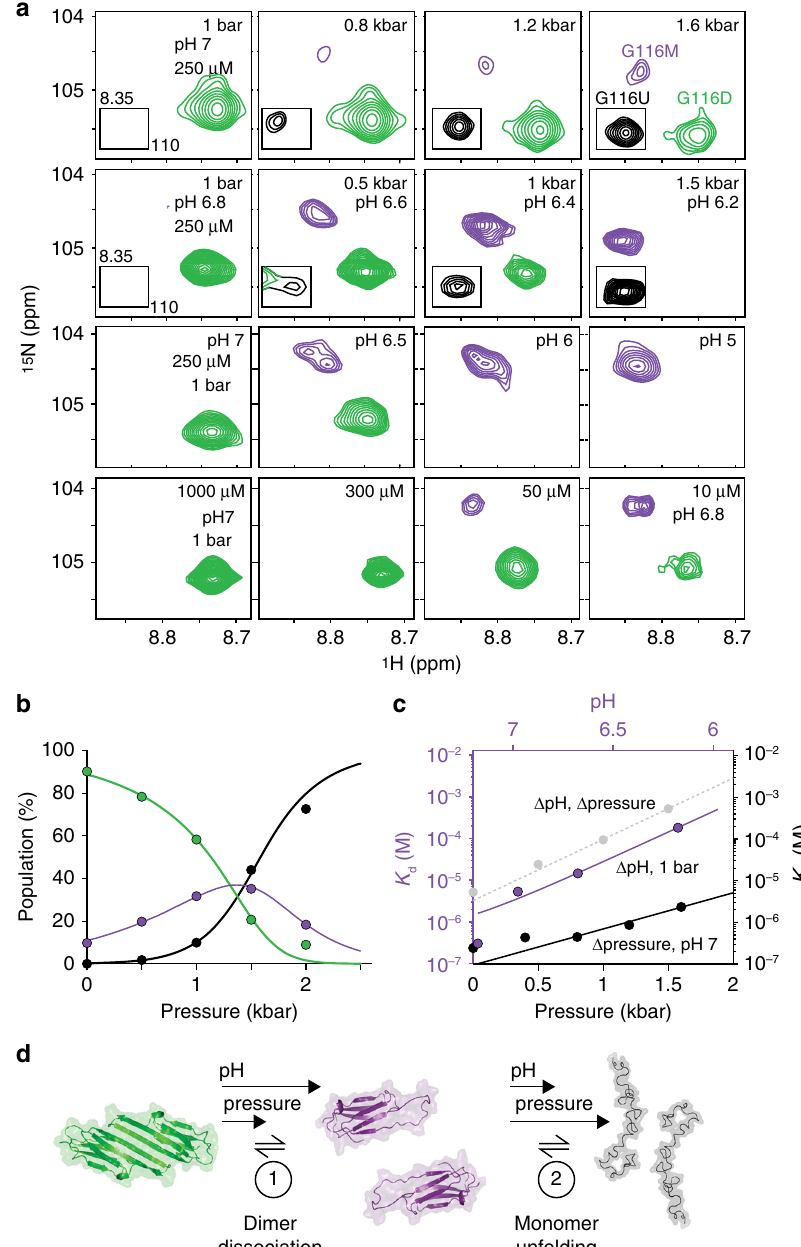
Fig. 6 High pressure and low pH stabilise the cHSP27 monomer. a NMR spectra of C137S, focusing on residue G116 as a function hydrostatic pressure, pH, and concentration. Shown here are four rows of spectra: increasing pressures at pH 7 in a baro resistant buffer, increasing pressures at pH 6.8 at 1 bar in phosphate buffer (pH decreases with pressure), decreasing pH at 1 bar, and decreasing protein concentration at pH 7 at 1 bar. Resonances from the dimer (green), monomer (purple), and unfolded (black) state are readily distinguishable. Decreasing concentration or pH and increasing pressure favour the monomerisation. At pressures greater than ~1.5 kbar, the unfolded form becomes the principally populated state. b Variations in NMR signal intensities with pressure from four residues that were unambiguously assigned in all three conformations were well explained (solid lines) by the quantitative 3-state equilibrium model shown. c The K d for dimerisation is shown as a function of pressure (black), pH (purple), or their combination (grey). d The three-state mechanism of C137S dimer dissociation, where low pH and high pressure favour the partially disordered monomer, before ultimately the monomers